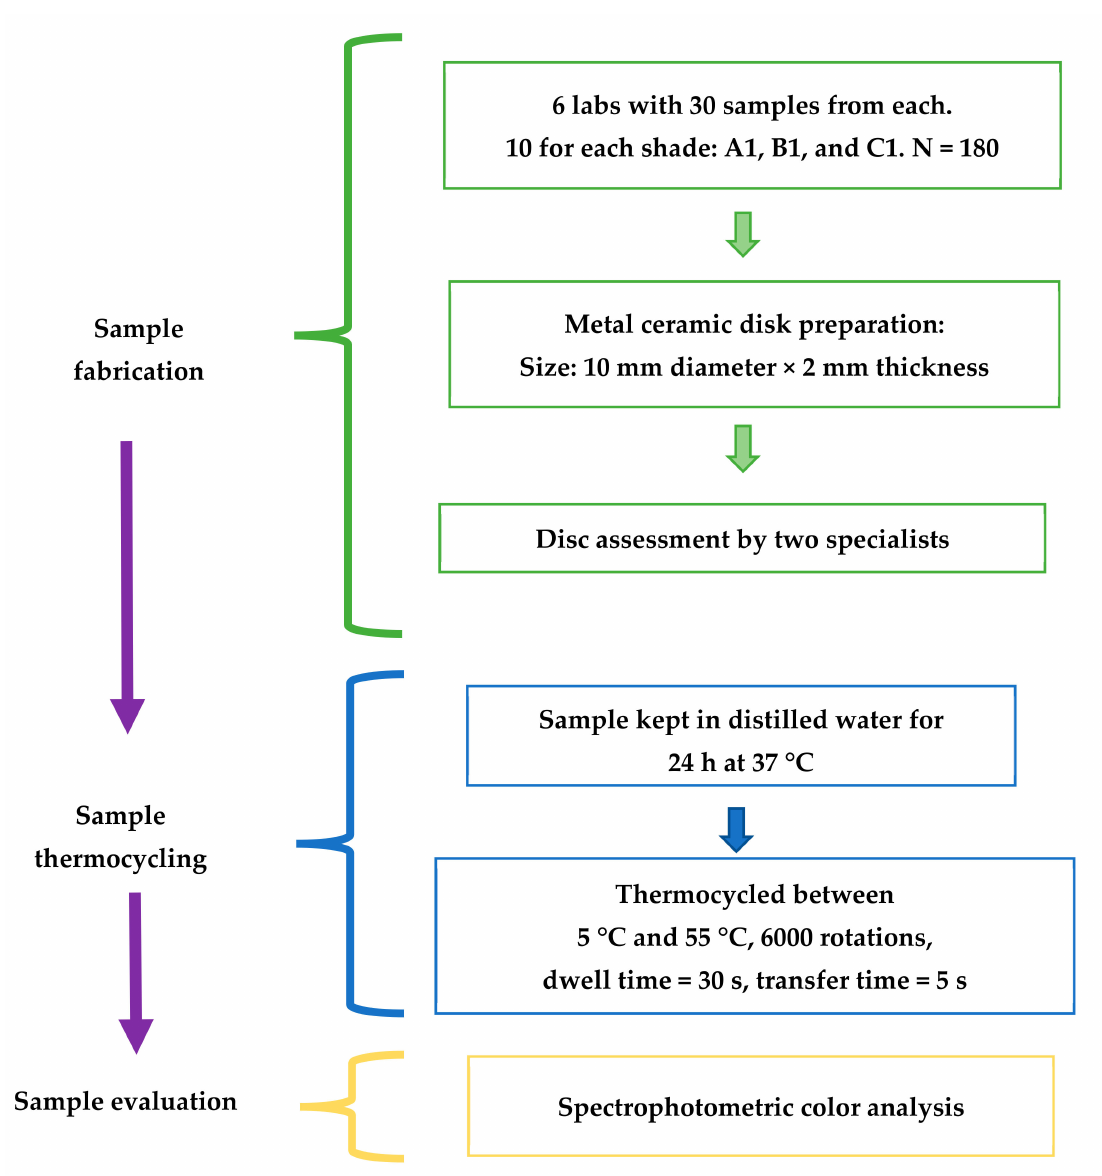
Figure 1. Flow chart for study